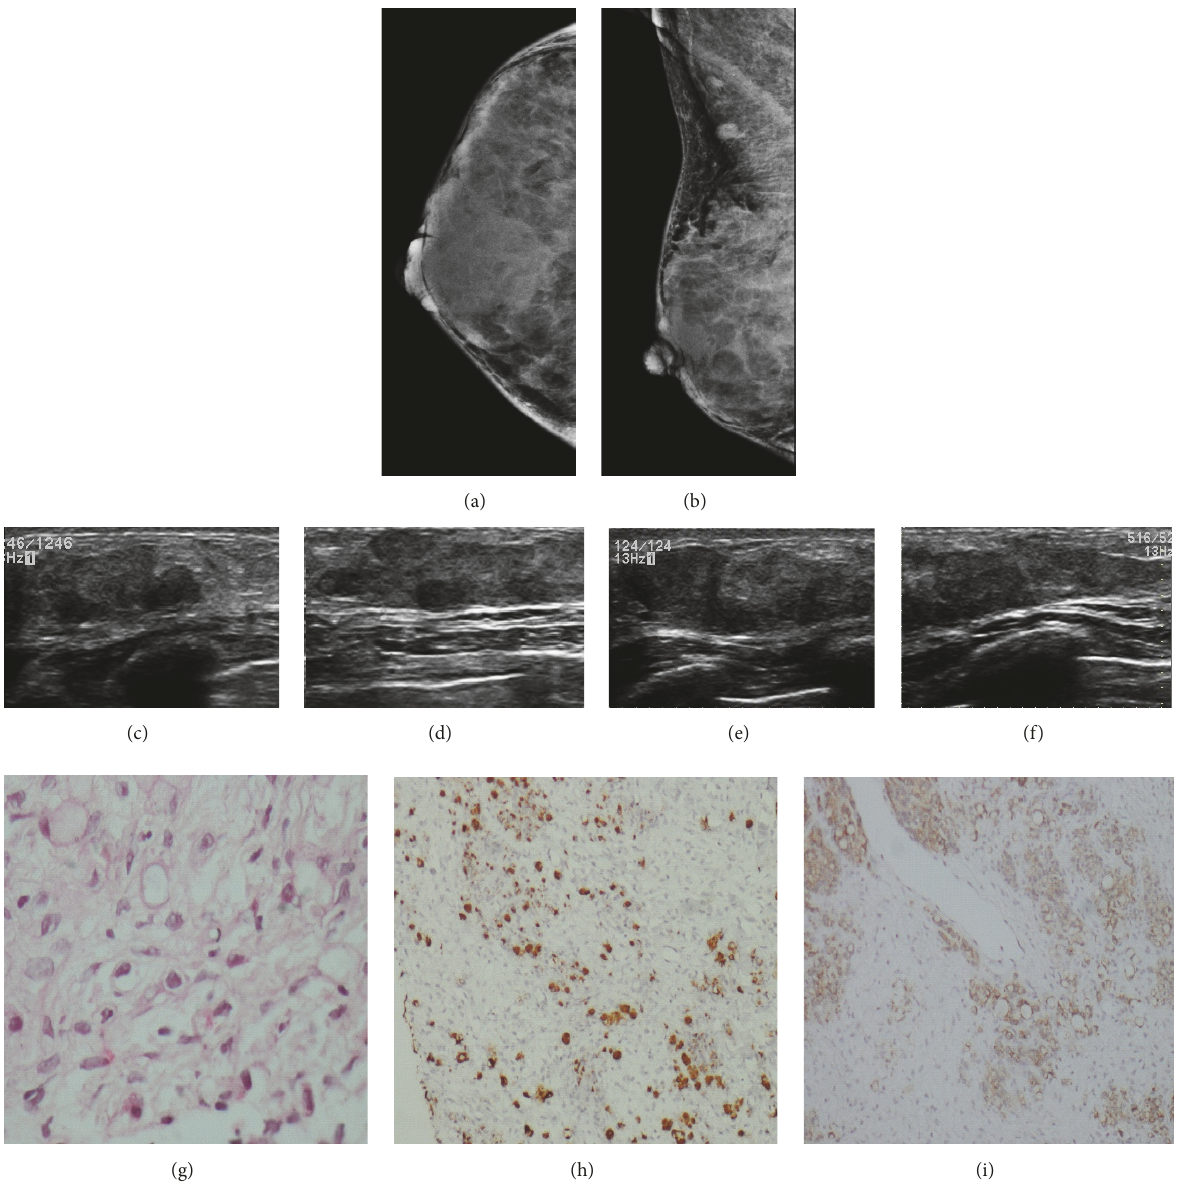
Figure 11: Case11. A 40-year-old woman with gastric signet ring-cell carcinoma. A solid mass in the upper-outerquadrant of the right breast was detected on initial exploration. ( a–b ) Mammogram showed extremely dense parenchyma of the right breast, which corresponded to multiple pseudonodular, hypoechoic, irregular masses with indistinct margins on ultrasound ( c–f ). HE staining and immunohistochemistry analysis of the metastases. HE staining revealed the malignant cells in the breast tumor ( g ), and the immunohistochemistryanalysis indicated that the cells were positive for MUC5AC ( h ) and CK20 ( j